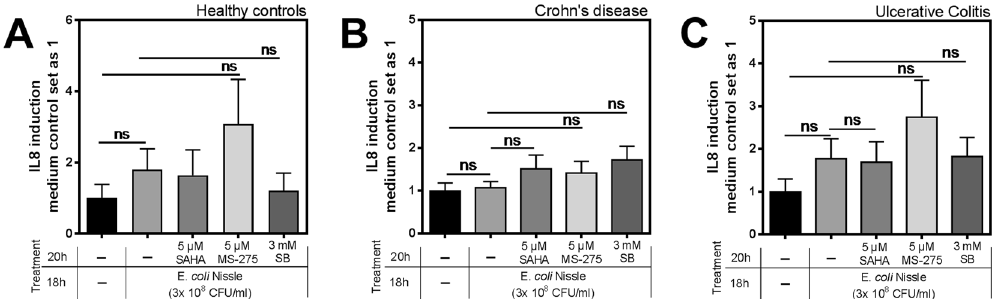
Figure 6. Effect of histone deacetylase (HDAC) inhibition on Interleukin 8 (IL8) expression in human colonic biopsies. IL8 expression in colonic biopsies of 13 healthy controls ( A ), 29 Crohn’s Disease (CD) ( B ), or 14 patients with ulcerative colitis (UC) ( C ) after treatment with EcN with or without simultaneous HDAC inhibition. Shown are relative fold changes compared to medium treatment alone according to 10 ng total RNA normalized to β actin expression. Data evaluated by Mann-Whitney u